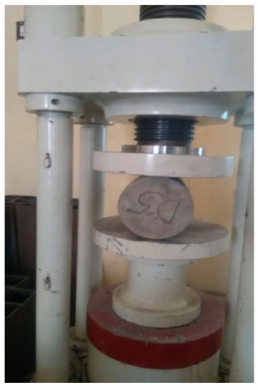
Figure 8. Split tensile strength test